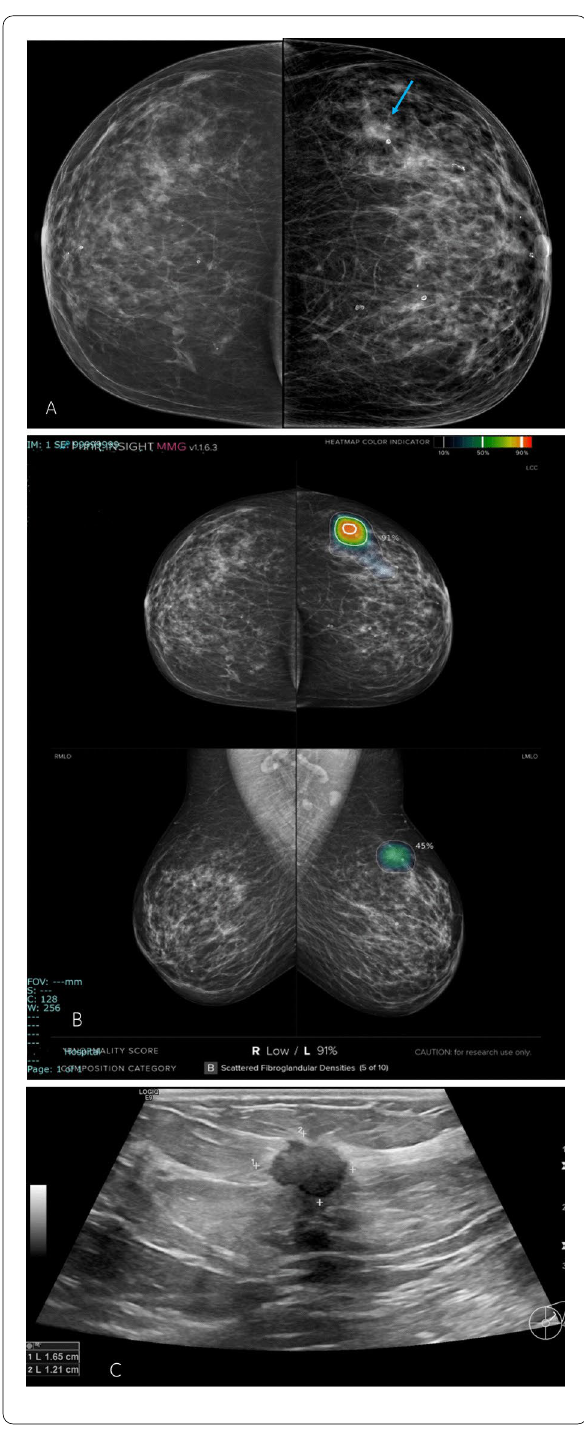
Fig. 1 Screening mammogram of a 60-year-old female patient. A Digital mammography cranio-caudal views of both breasts. Left breast upper outer focal area of increased density and distortion (arrow). B AI heatmap showed left breast upper outer high intense color hue of 91% score of malignancy suspicion. C On ultrasound, a small indistinct solid mass was detected. Wire localization and excision biopsy revealed IDC. Localization of the disease was more feasible by the aid of the AI and the suspicion of malignancy was confirmed